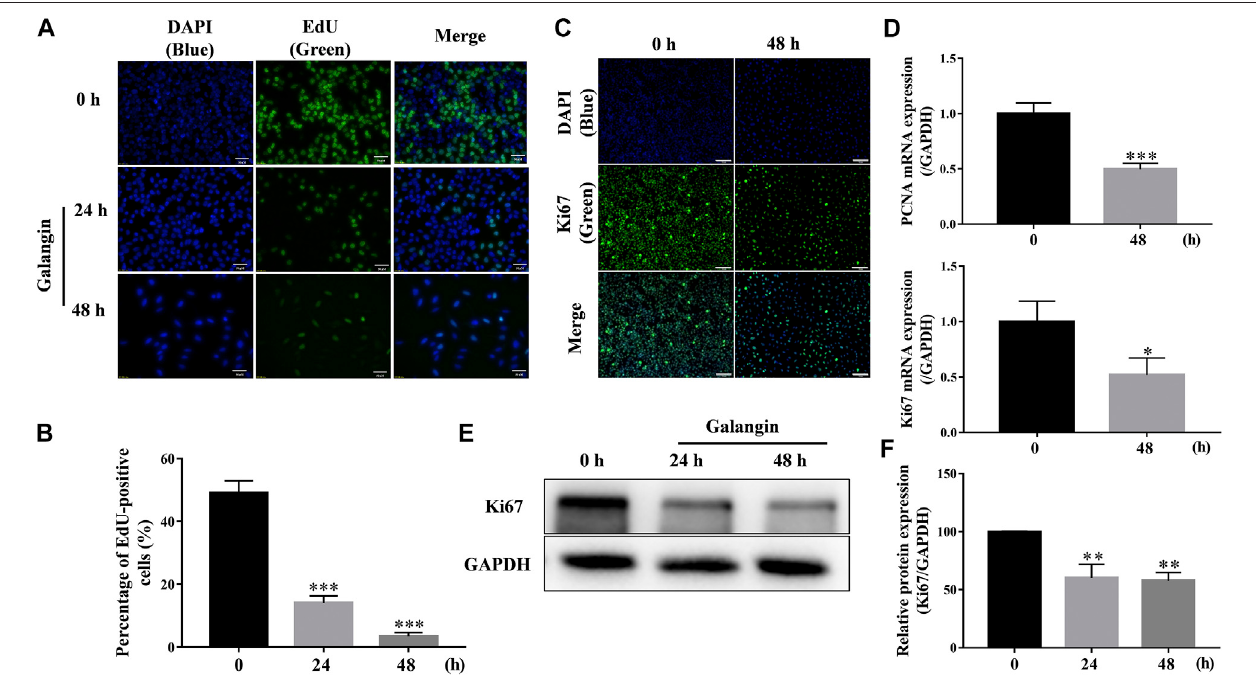
FIGURE 3 | Galangin inhibits proliferation of MGC 803 cells. (A – B) Galangin (20 μ M) decreased cell proliferation of MGC 803 cells after treatment for 24 and 48 h detectedbyEdUstaining.Scalebar,50 μ m. (C) Galangin(20 μ M)inhibitedproteinexpressionofKi67inMGC803cellsdetectedbyICCstaining.Scalebar,100 μ m. (D) Galangin (20 μ M) downregulated mRNA expression of PCNA and Ki67 after treatment for 48 h. (E – F) Galangin (20 μ M) decreased protein expression of Ki67 in MGC 803 cells after treatment for 24 and 48 h analyzed by Western blotting analysis. All of the data were shown as mean ± SD, and differences among two groups ( Figure 3D ) were analyzed by the Student ’ s t -test, and differences among ≥ 3 groups ( Figures 3B,F ) were analyzed via one-way ANOVA with Dunnett test by using GraphPad 7.0 software; * p < 0.05; ** p < 0.01; *** p < 0.001, compared with control group. n ≥ 3.